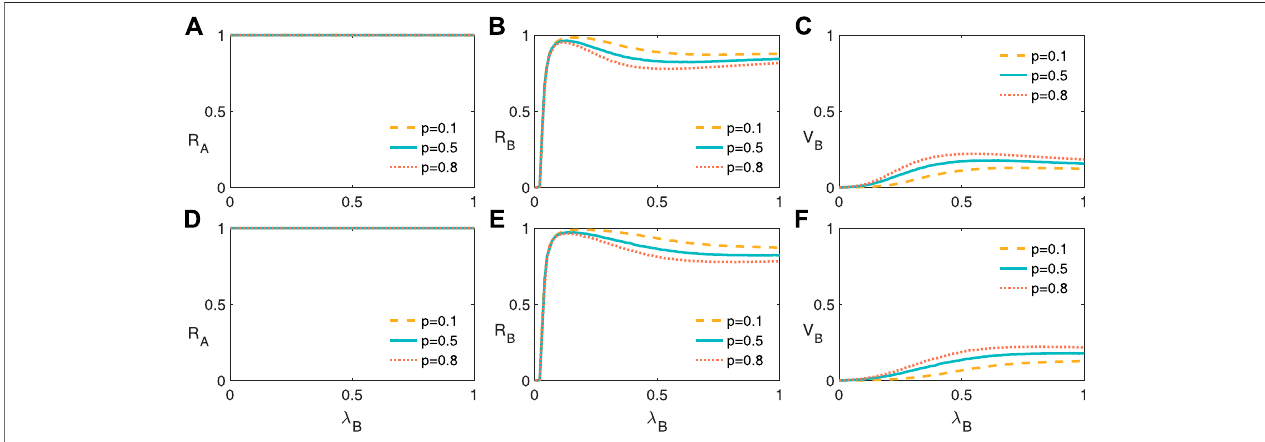
FIGURE 4 | (Color online) The fi nancial risk spreading on two-layer networks for a given values of fi nancial risk transmission probability. Final information spreading size R A (A) , fi nal fi nancial risk spreading size R B (B) , and vaccination size R B (C) versus information transmission probability λ B with fi nancial risk transmission probability λ A =0.5. R A (D) , R B (B) ,and R B (C) versus φ = 0.9.